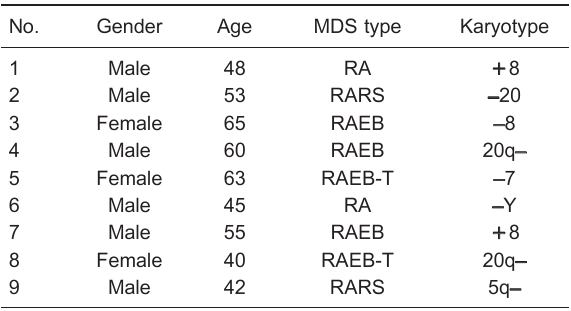
Table 2. Abnormal karyotype of mesenchymal stem cells (MSCs) from the myelodysplastic syndromes group.